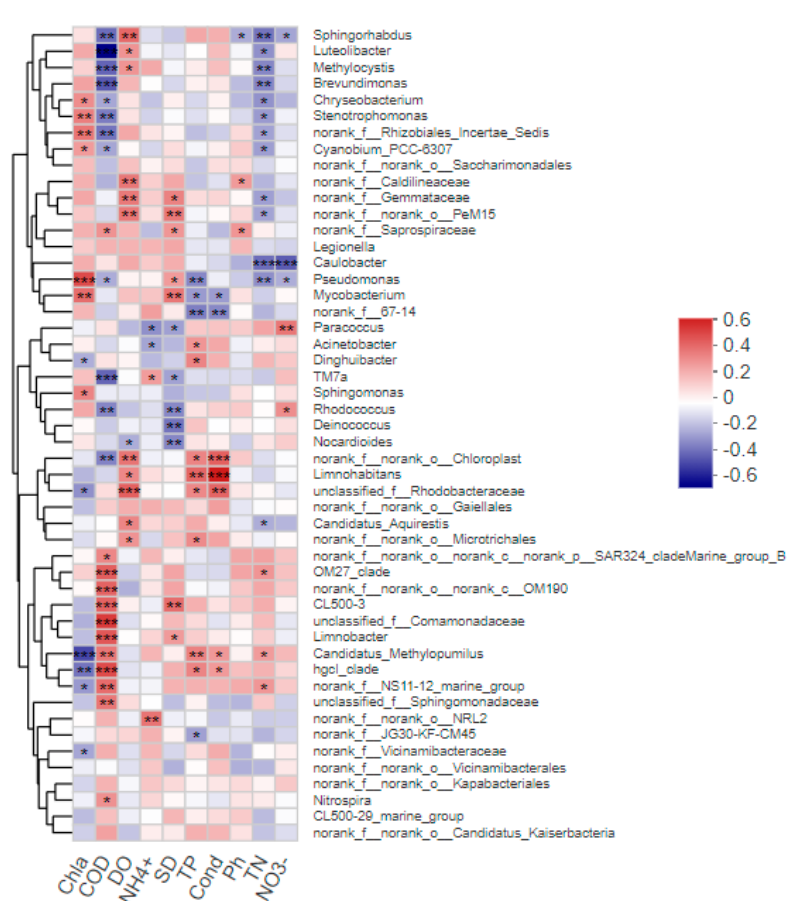
Figure 7. The relationship between species (genus level) and environmental factors was analyzed by heatmap. The X-axis and Y-axis are environmental factors and species, respectively, and the cor- relation R value and p value are obtained by calculation. The R value is shown in different colors in the figure, and if p value is less than 0.05, it is indicated by *. * 0.01 < P ≤ 0.05 ， ** 0.001 < P ≤ 0.01 ， *** P ≤ 0.001